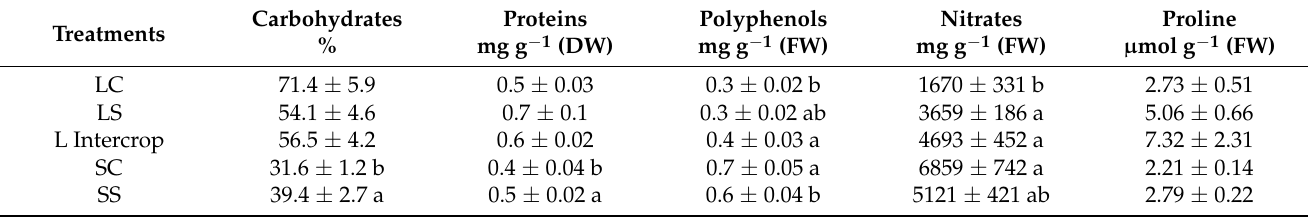
Table 5. Carbohydrate, protein, polyphenol, nitrate and proline content in edible leaves. Carbohydrates Treatments